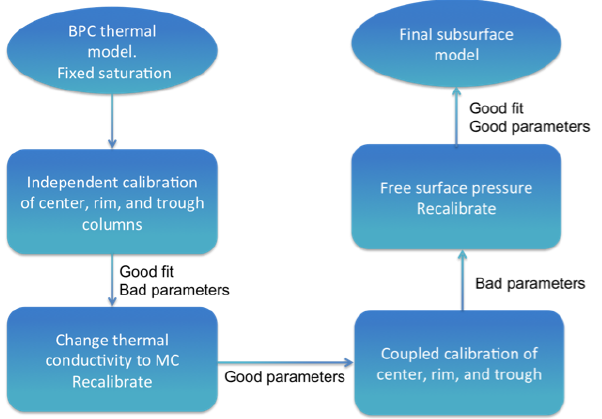
Figure 4. The ModEx cycle as applied here to subsurface thermal hydrologic system in freezing–thawing